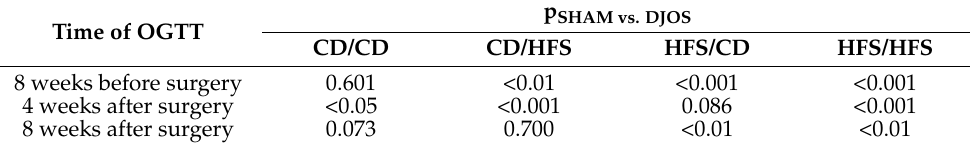
Table 3. Comparison of glucose concentration changes in time during the oral glucose tolerance test (OGTT) in Sprague–Dawley rats subjected to control (SHAM) surgery and different dietary regimes and Sprague–Dawley rats subjected to duodenojejunal omega switch (DJOS) surgery and different dietary regimes.